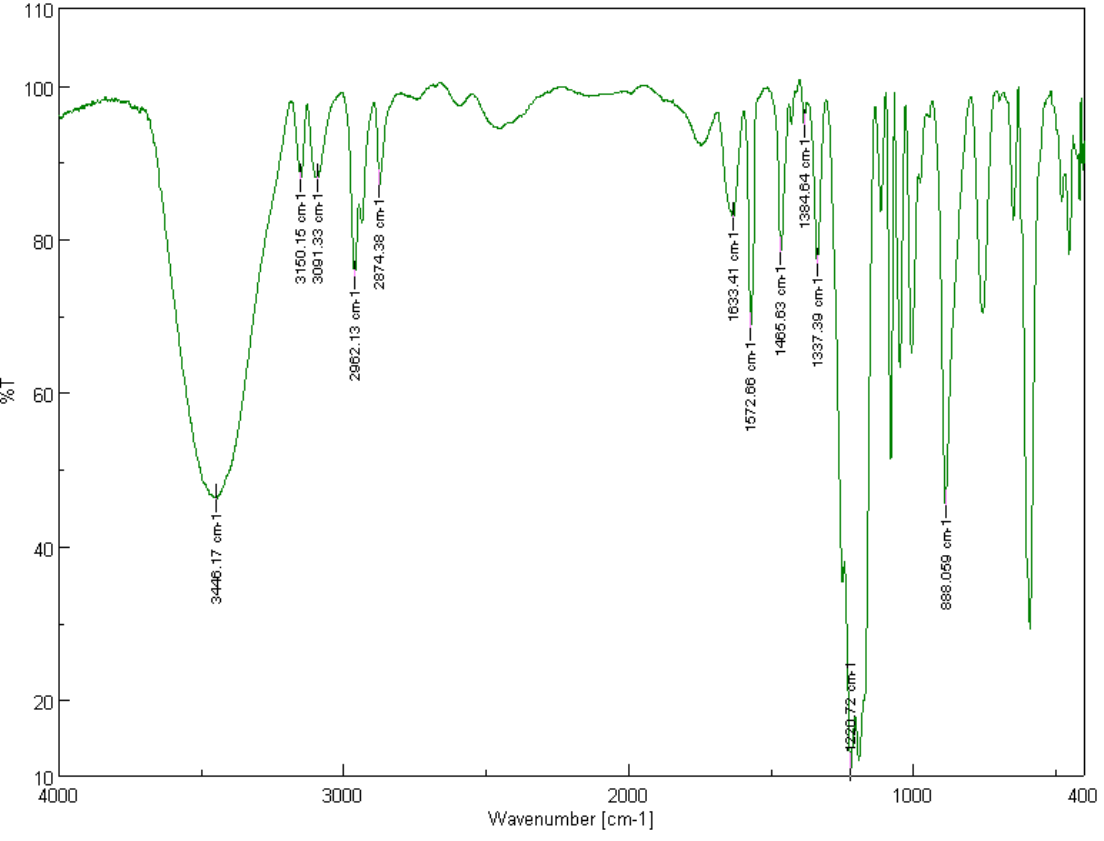
Figure 13. Solid-state FT-IR spectrum of the recycled [BMIM][HSO 4 ]. Sample pellet with KBr, number of scans: 32, resolution: 4.0 cm − 1 .